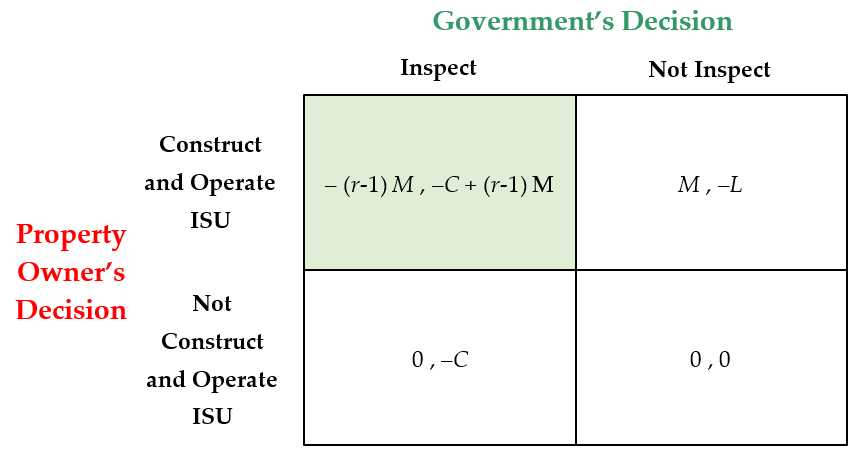
Figure 3. The choices and payoffs in monitoring and constructing & operating